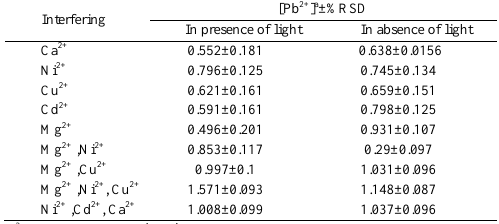
Table 2. Investigation of interfering ions effect at concentration level of removal of 5 mg/l on removal of lead (II) ion (Initial concentration was 200 mg/l) by Ce-TiO2/bentonite nanocomposite [Pb 2+ ] a ±%RSD Interfering In presence of light